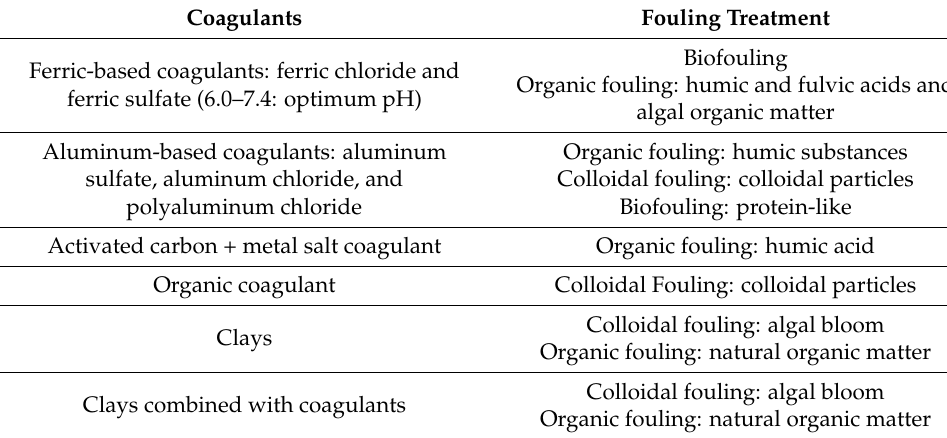
Table 4. Main coagulants and targeted pollutants. Coagulants Fouling Treatment Biofouling Ferric-based coagulants: ferric chloride and Organic fouling: humic and fulvic acids and ferric sulfate (6.0–7.4: optimum pH) algal organic matter Aluminum-based coagulants: aluminum Organic fouling: humic substances sulfate, aluminum chloride, and Colloidal fouling: colloidal particles polyaluminum chloride Biofouling: protein-like Activated carbon + metal salt coagulant Organic fouling: humic acid Organic coagulant Colloidal Fouling: colloidal particles Colloidal fouling: algal bloom Clays Colloidal fouling: algal Clays combined with coagulants